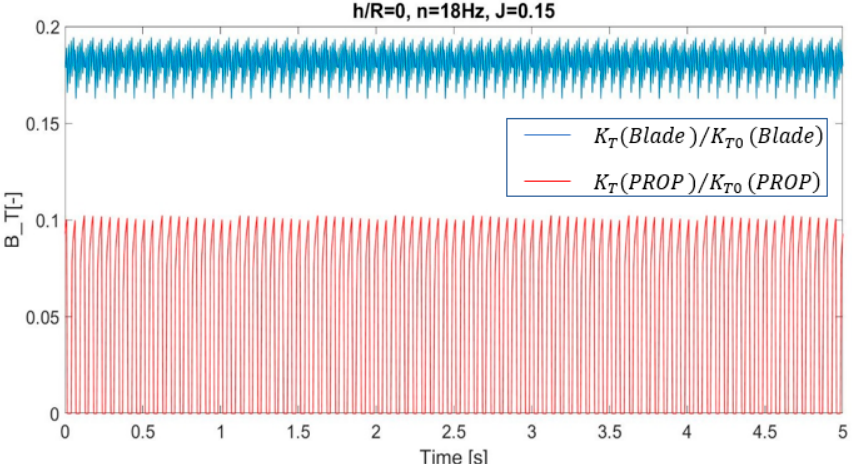
Figure 18. Calculation of thrust loss factor as a function of blade position.